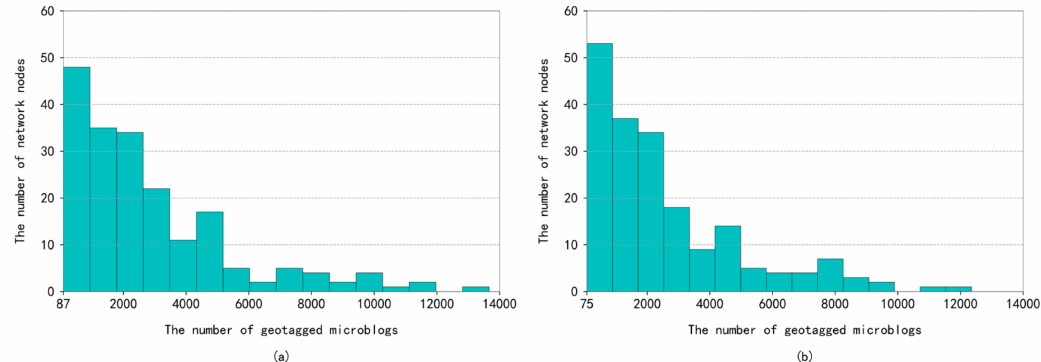
Figure 3. The number of distributions of geotagged microblogs for each node in daytime ( a ) and nighttime ( b ).